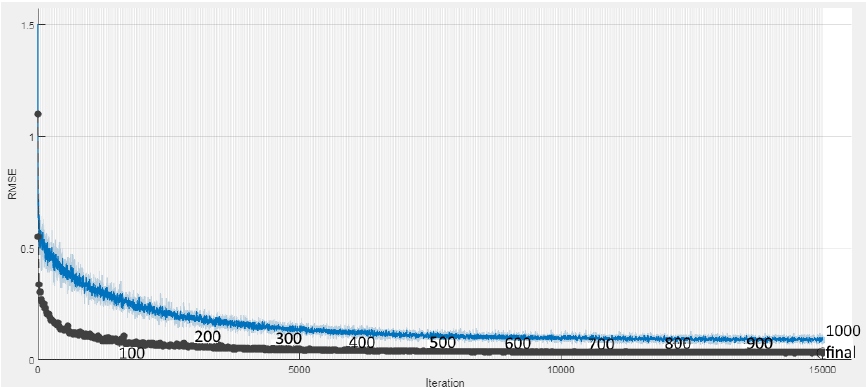
Figure 7. Root mean square error for training set (blue line) and validation set (black line).